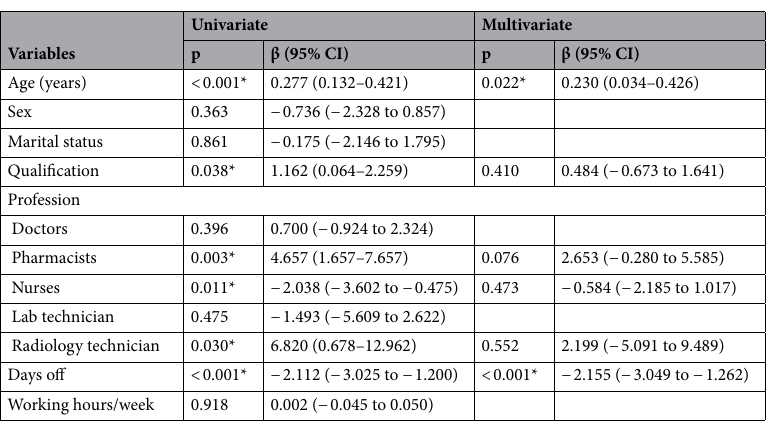
Table 4. Regression analysis for the parameters affecting burnout syndrome among frontline healthcare professionals in Sudan. R 2 = 0.225, F = 8.402*, p < 0.001*. β: Unstandardized Coefficients C.I: Confidence interval. *Statistically significant at p ≤